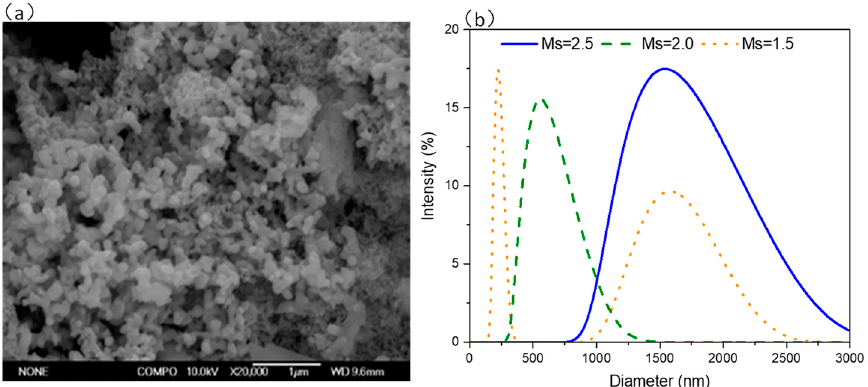
SiO 2 /Na 2 O ratio of 2.0 and 1.5, the mean hydrodynamic radius became 560.2 nm and 246.2 nm, respectively, which are lower than those corresponding to the ratio of 2.5.